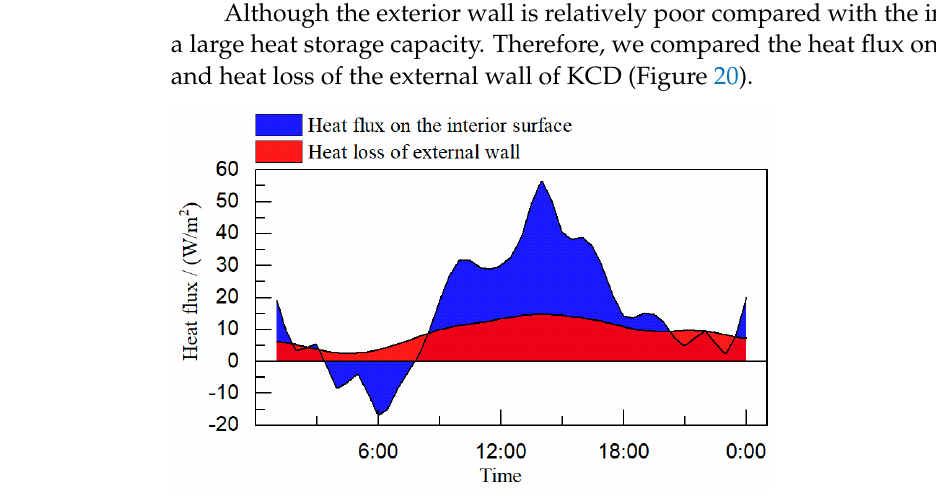
Figure 19. Heat transfer components and superposition of the external wall.